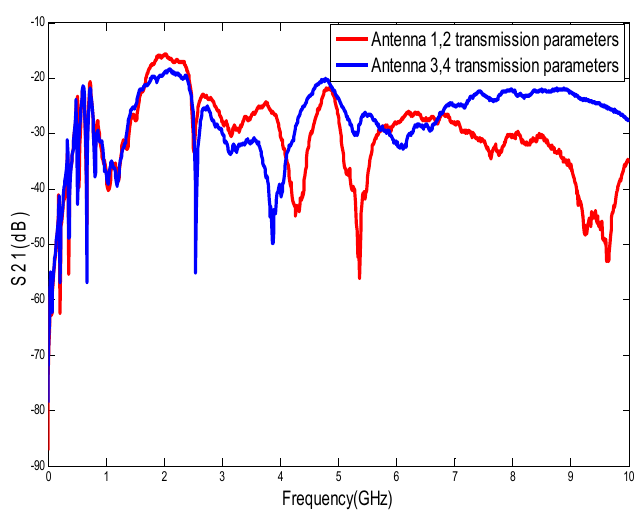
Figure 15. Transmission parameter curve of the proposed antenna.